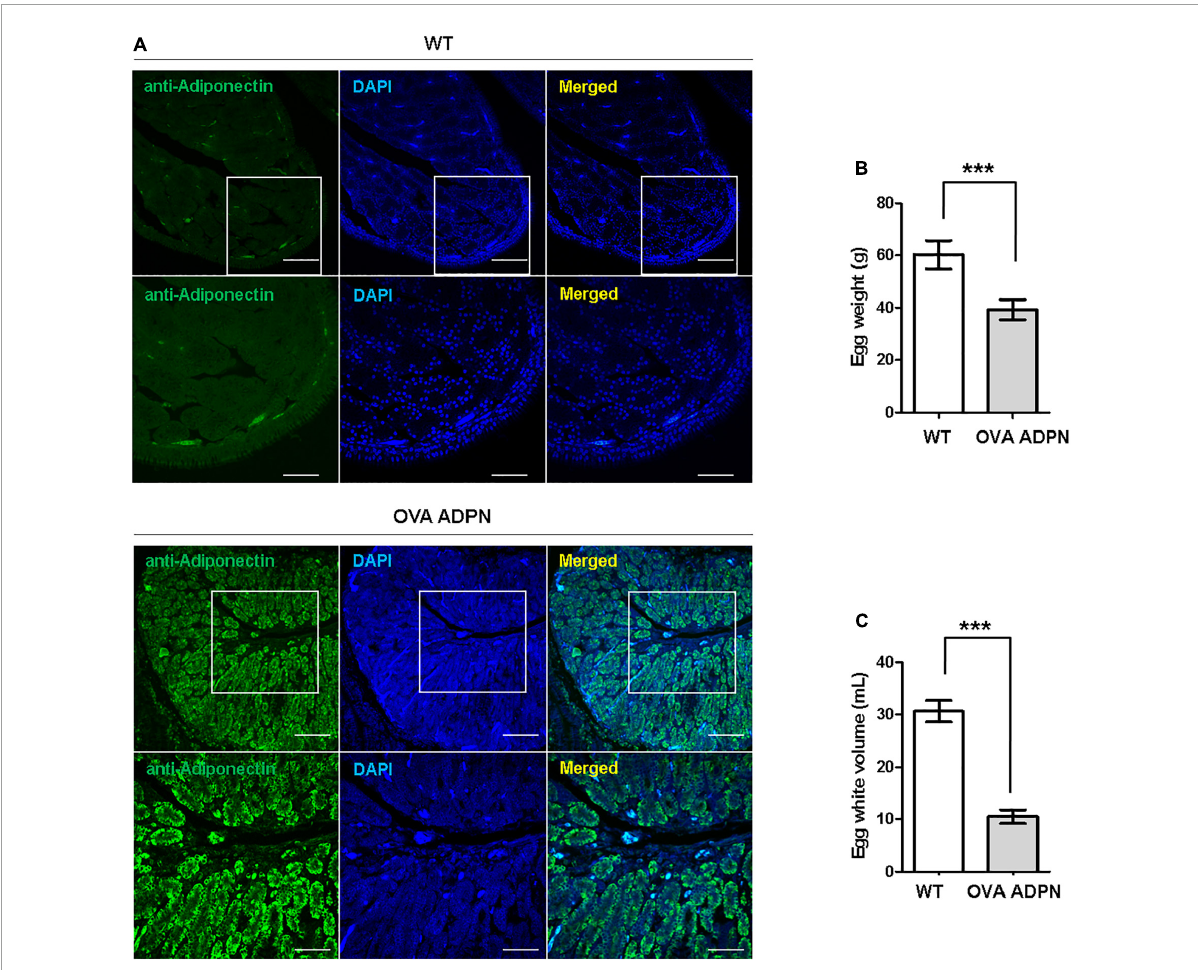
FIGURE2 Characterization of G 1 OVA ADPN KI hen’s oviducts and eggs. (A) Immunohistochemistry of human adiponectin in magnum part of OVA ADPN KI G 1 and wild type (WT) hen. Scale bars = upper panel: 100 µ m, lower panel: 50 µ m. (B) Comparison of OVA ADPN KI chicken egg and WT egg for egg weight ( n = 21 in WT, 20 in OVA ADPN KI). ***P < 0.001. (C) Comparison of the egg white properties of G 1 OVA ADPN hen eggs with WT egg white volume ( n = 15 in WT, 17 in OVA ADPN KI). ***P <